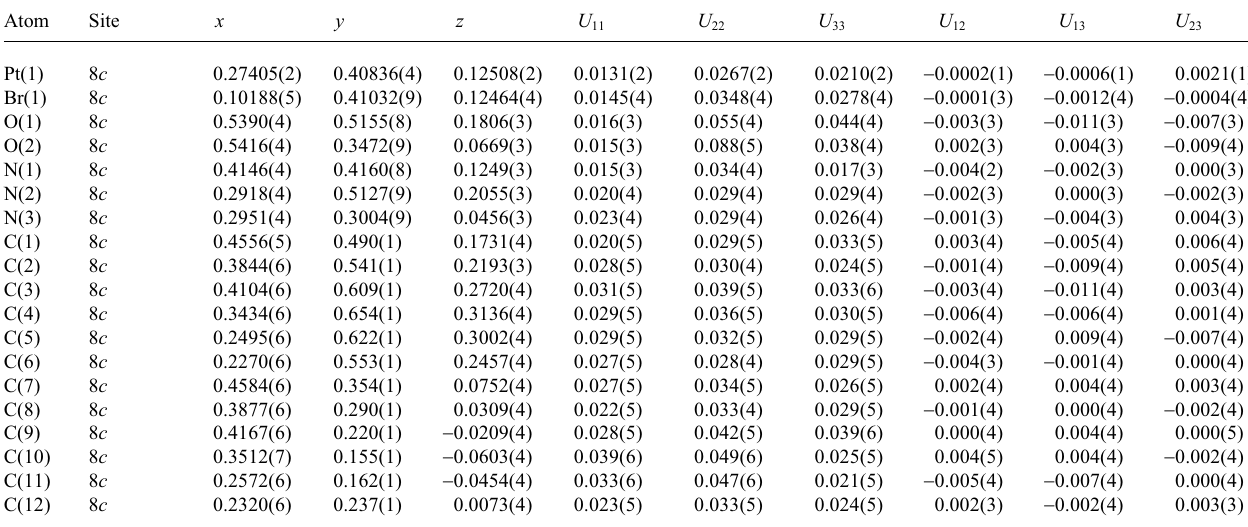
Table 3. Atomic coordinates and displacement parameters (in Å 2 )